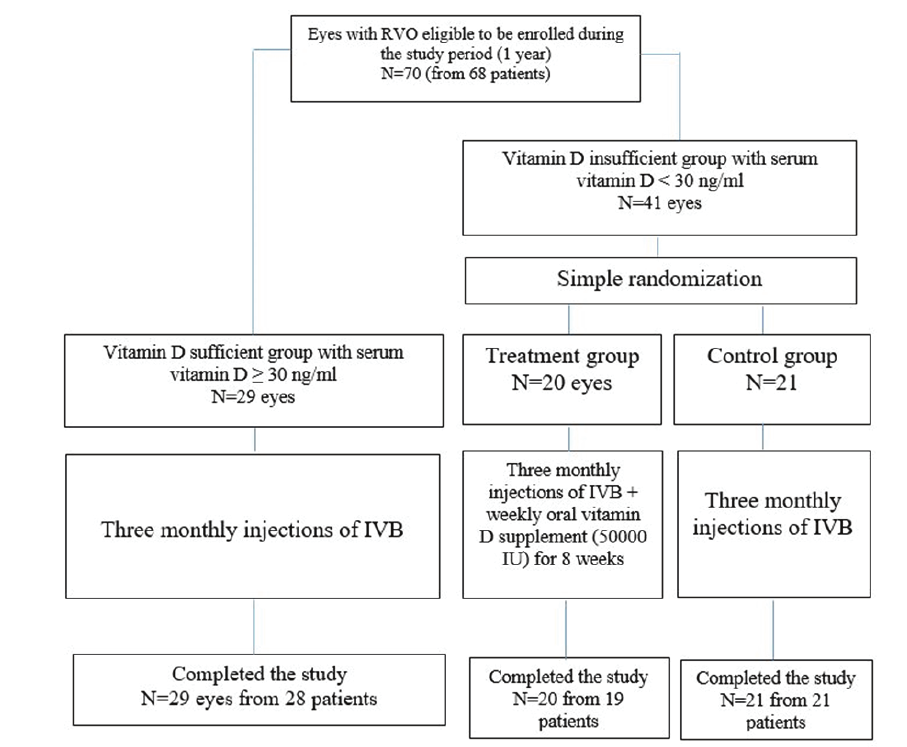
Figure 1. Flowchart of patient’s enrollment. IVB, intravitreal bevacizumab.